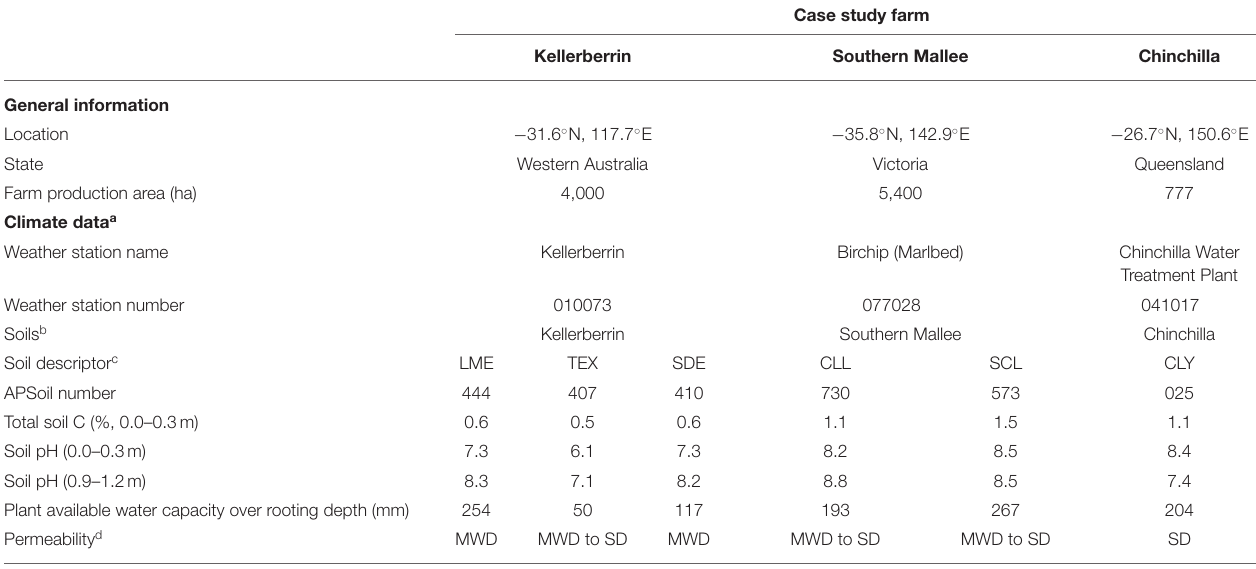
TABLE 1 | Location and soils information for the Kellerberrin, Southern Mallee, and Chinchilla case study